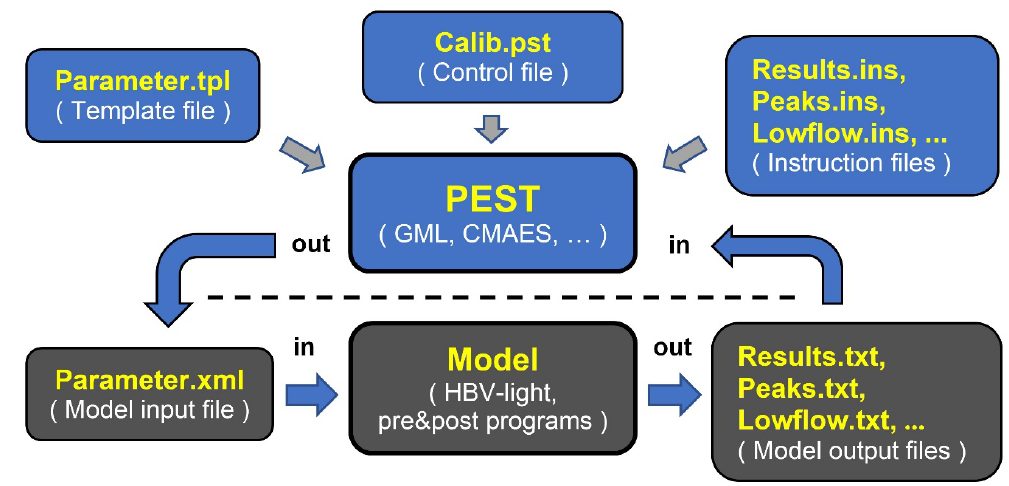
6 of 20 Table 1. List of parameters with their units and description. Parameter name